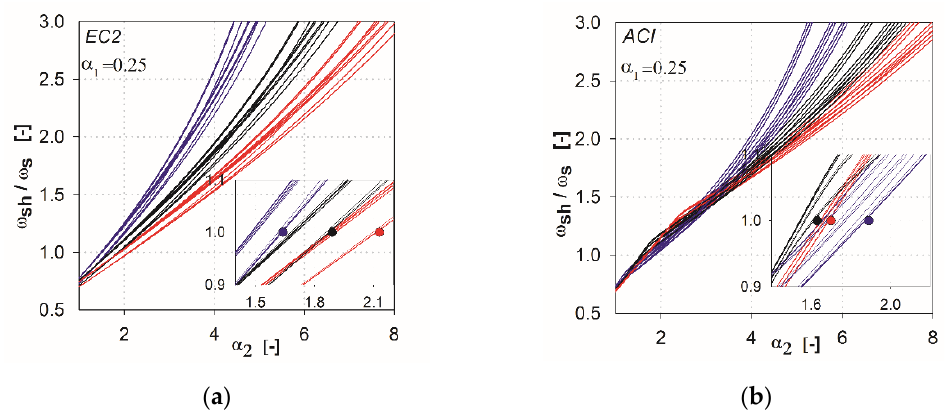
Figure 6. Graphs obtained for the parameter 𝛼 1 = 0.25 : ( a ) for the EC2 standard; ( b ) for the ACI code.